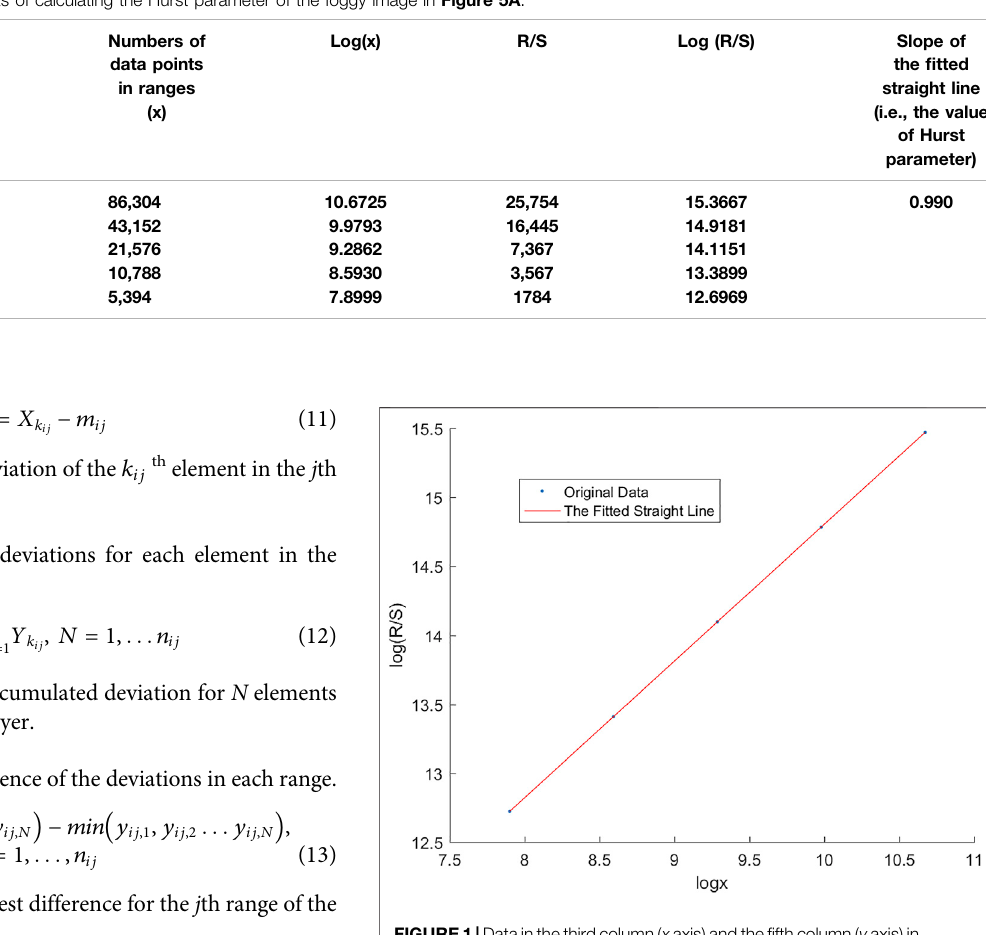
FIGURE1| Datainthethirdcolumn( x axis)andthe fi fthcolumn( y axis)in Table 1 and their fi tting straight line whose slope is